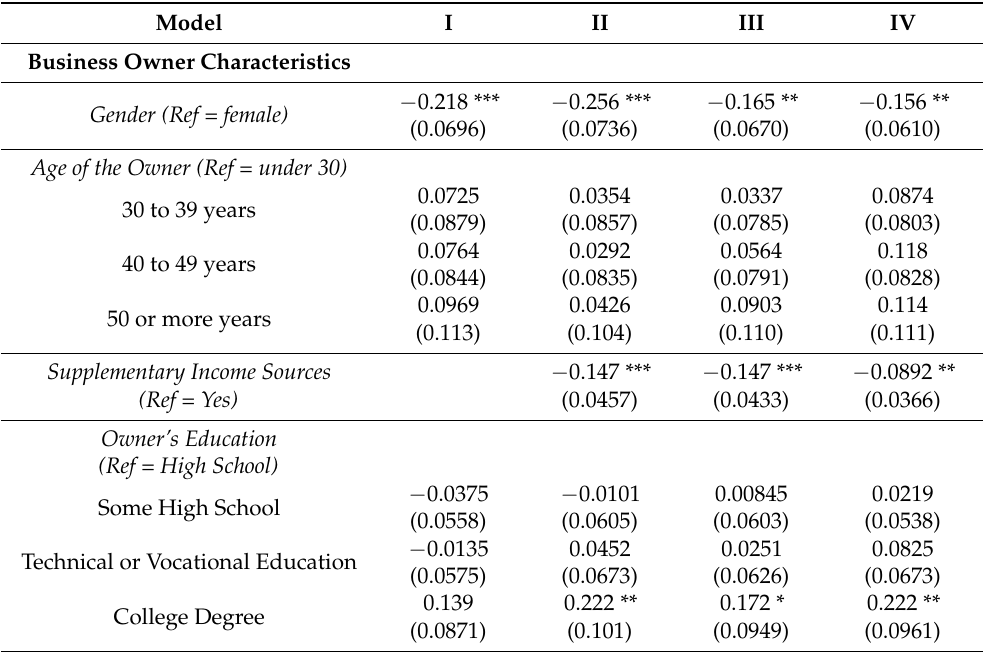
Table 3. Ordered Logit Model for Business Revenue (High Sales Revenue) Among Latino-Owned Small Businesses: Marginal Effects and Standard Errors +